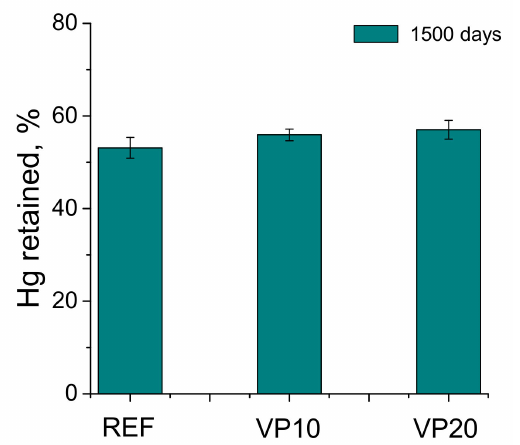
Figure 5. Results of percentage of mercury retained at the end of porosimetry test for the analyzed